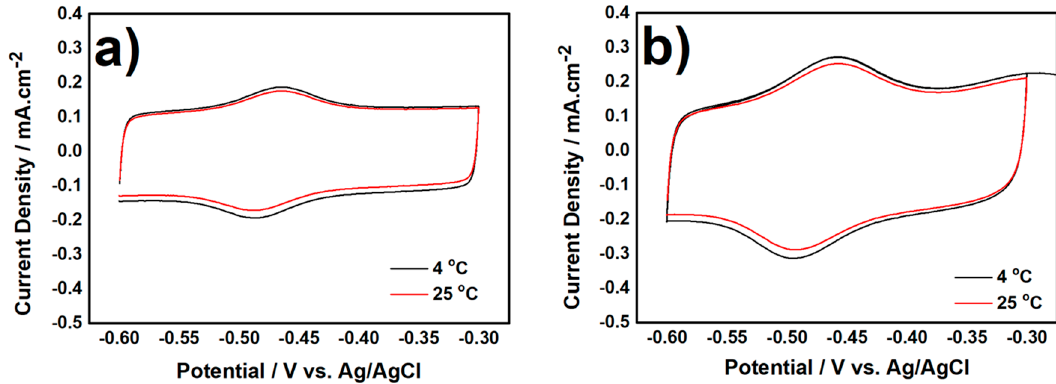
Figure 4. CV curves of ( a ) CNT/GOx and ( b ) CNT/PEI/GOx at scan rate 100 mV · s − 1 stored for 120 days. All experiment under anaerobic condition by feeding N 2 gas with flow rate 100 mL · min − 1 in PBS 0.1 M pH 7.4 as the electrolyte.